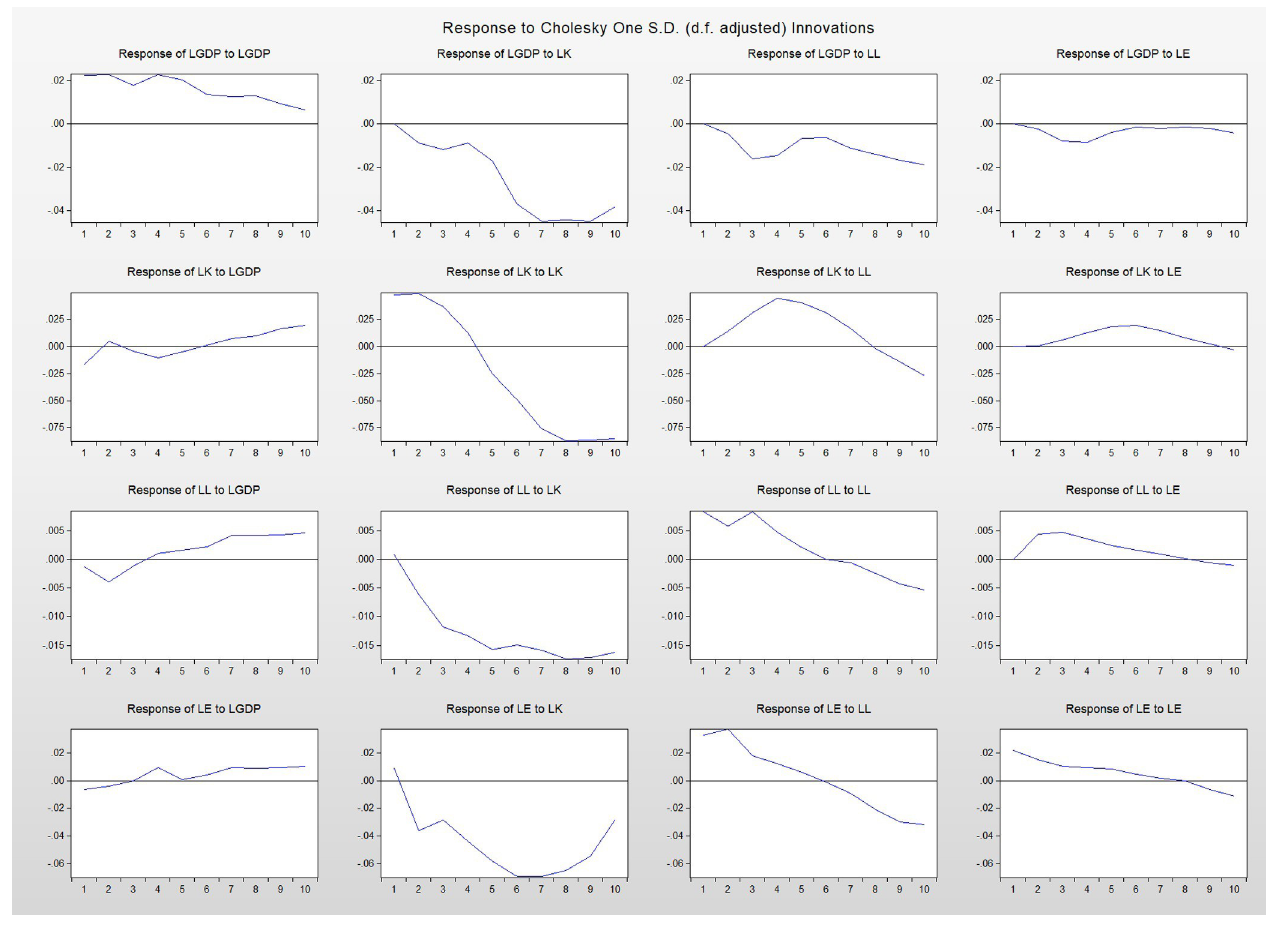
Fig 7. Impulse response